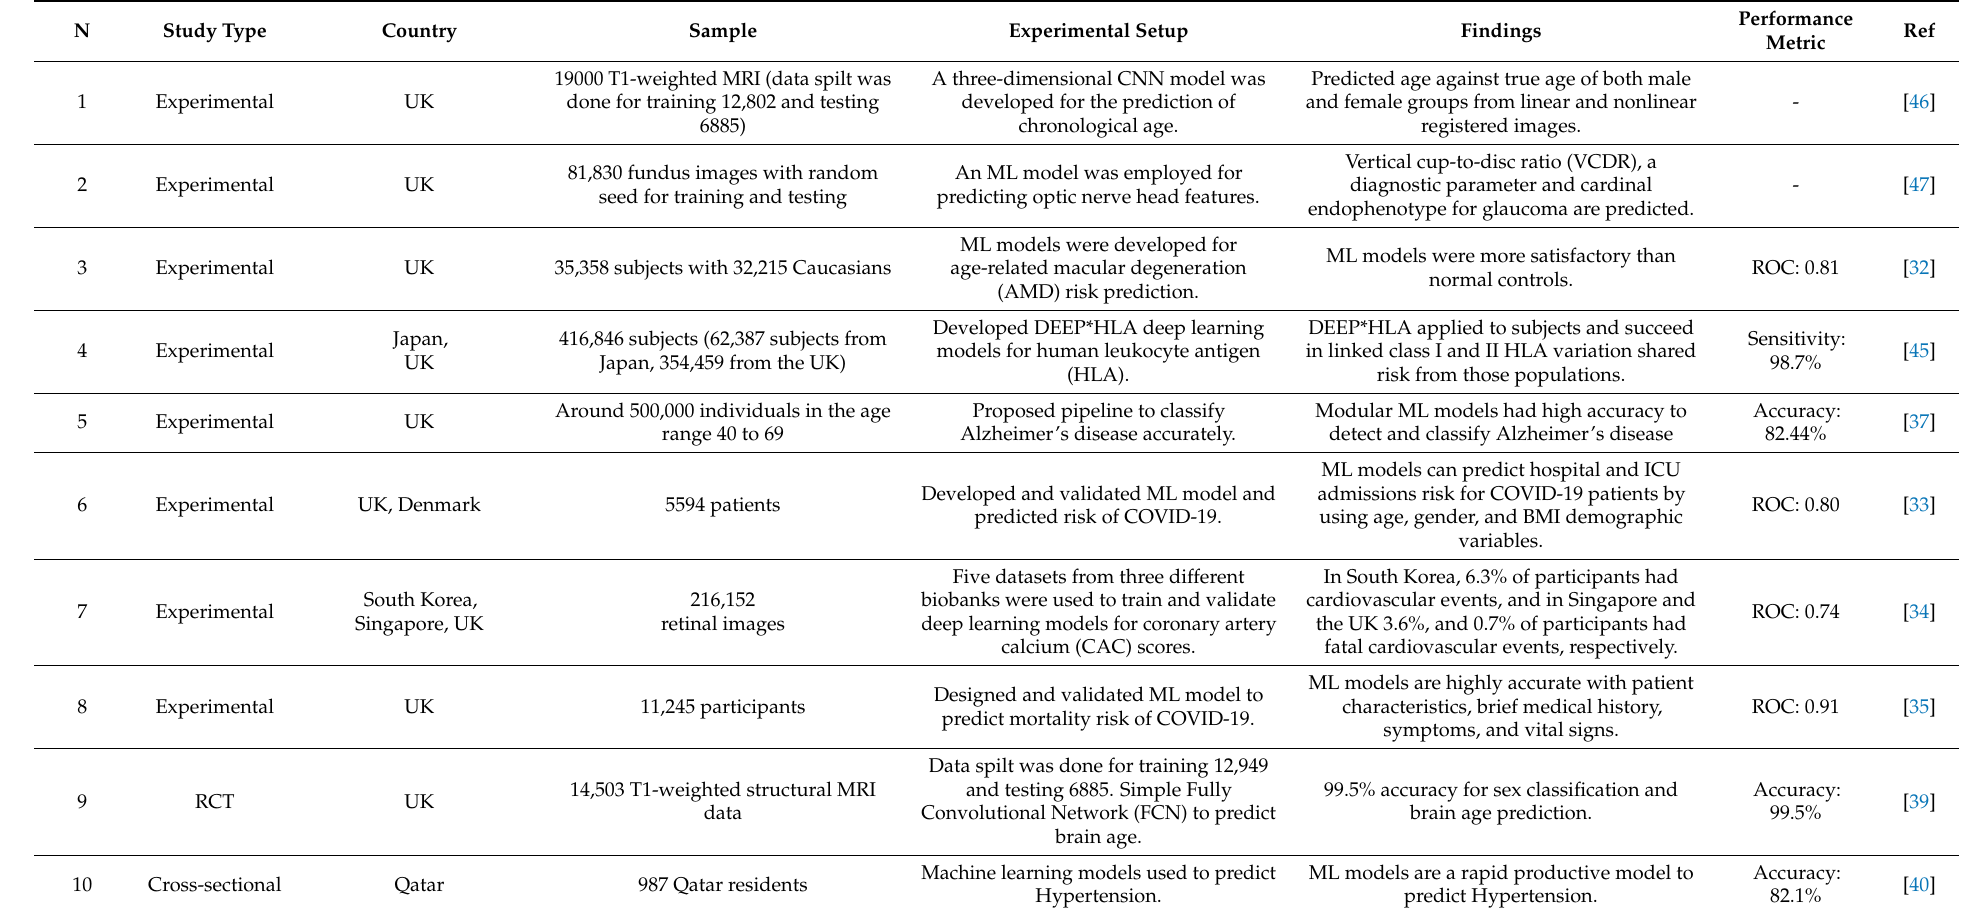
Table 1. Summary of findings for the role of AI techniques in the management of global biobanking